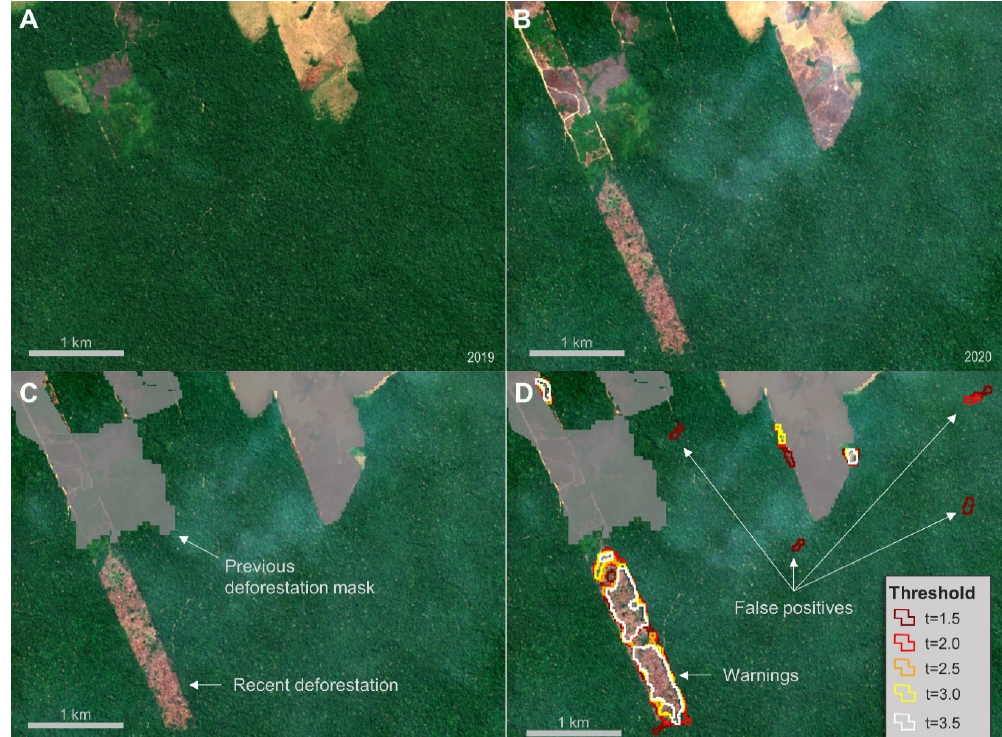
Figure 15. ALT detection results in a deforested area in Apuí municipality, Amazonas state (Brazil). ( A ): Optical image before deforestation. ( B ): Optical image after deforestation. ( C ): Previous deforestation mask showed in grey. ( D ): Detected deforestation polygons. The application of the global